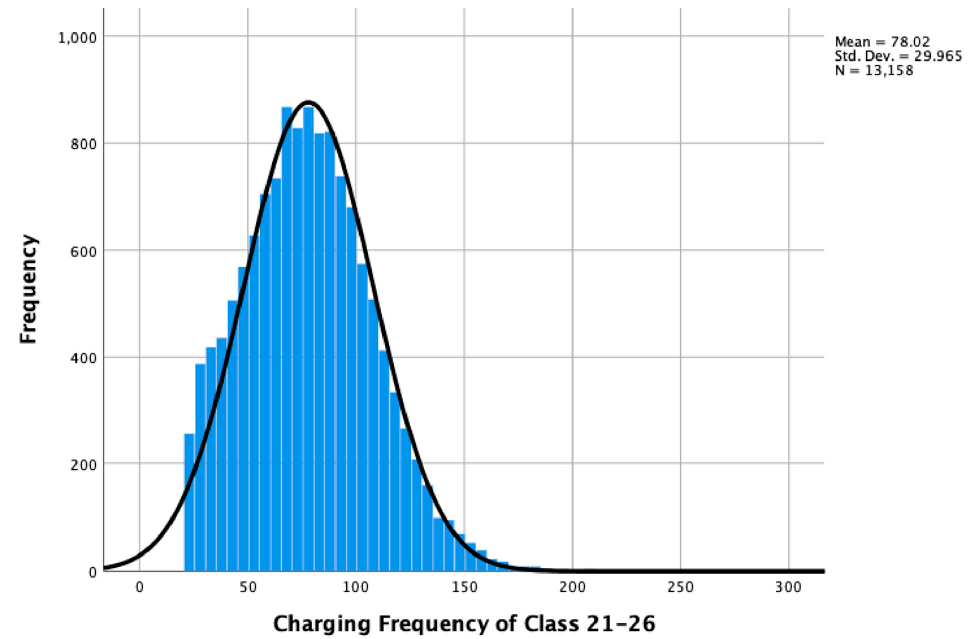
Figure 8. Comparison the density function of normal distribution and the charging frequency of classes 21–26.